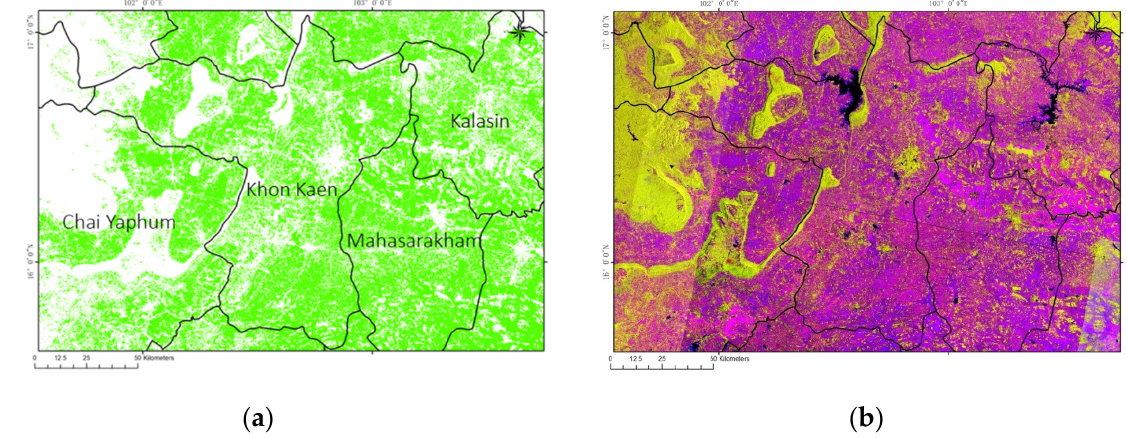
Figure 17. Paddy rice mapping result of Khon Kaen (northeast Thailand): ( a ) paddy rice mapping result and ( b ) false-color image of the temporal features.